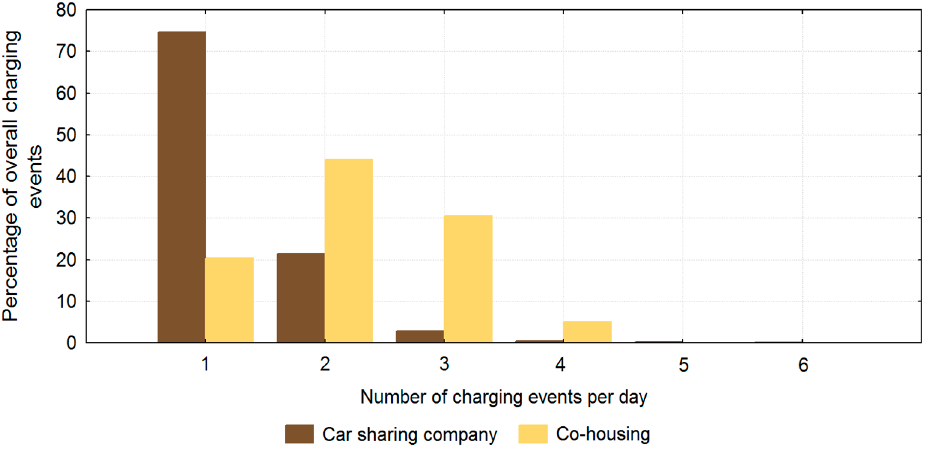
Figure 7. Charging behavior—the number of charging events per day.